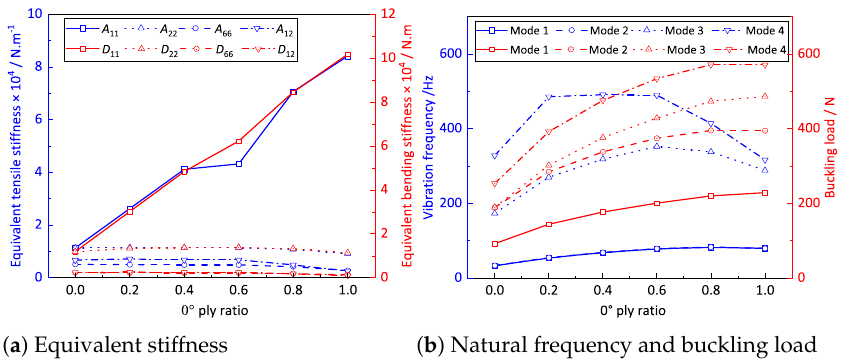
Figure 16. Effects of the structural parameters on the effective performances of the OSFP.